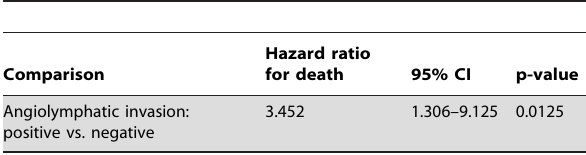
Table 7. Multivariate analysis of patients not treated with adjuvant therapy: overall survival.